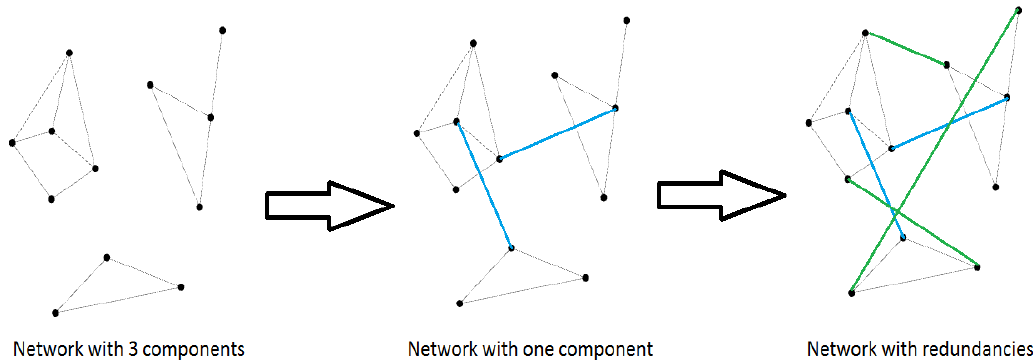
Figure 5. Connection of the three components of a network with two links. Building redundancies adding more